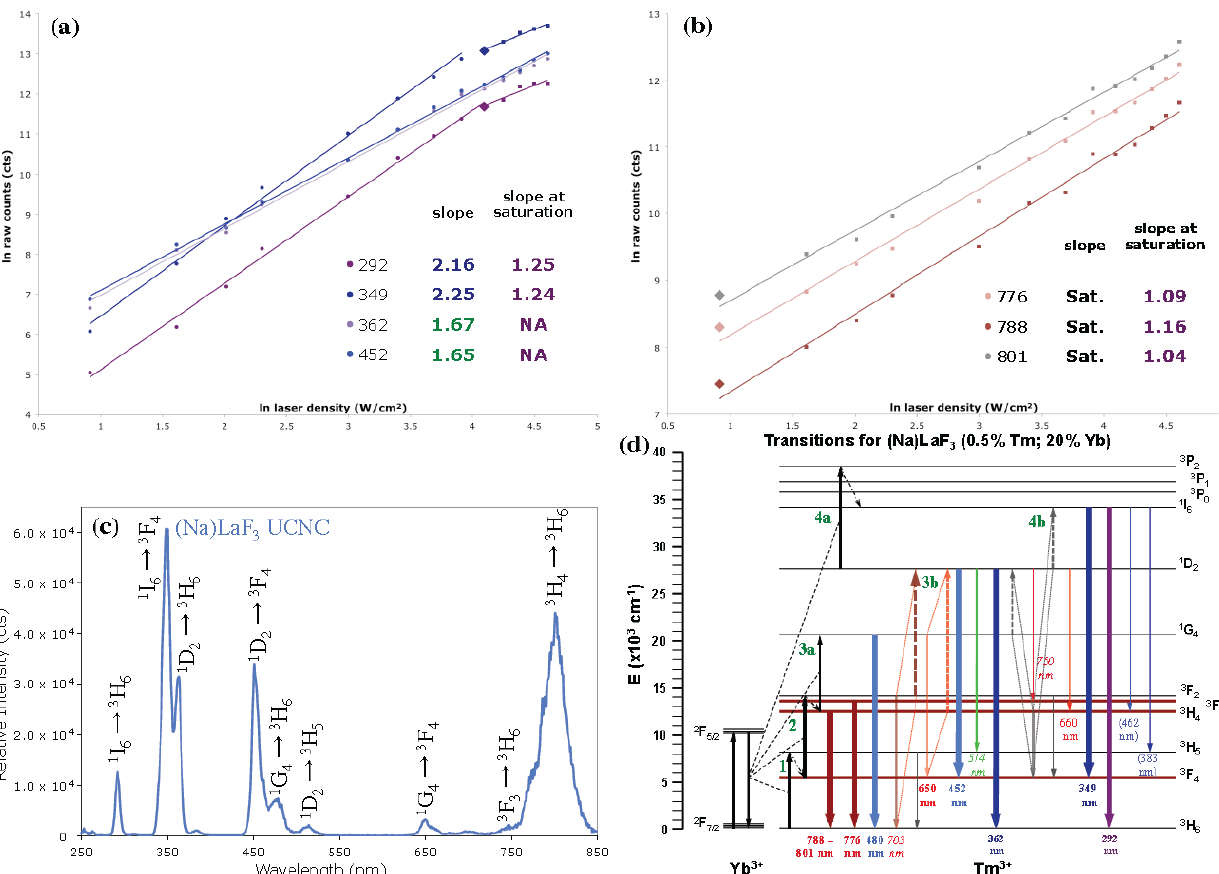
Figure 5. Emission intensity vs . 980 nm laser power density (W/cm 2 ), ln-ln IvP plot of UCNC in ( a ) UV/blue and ( b ) NIR regime, noting 0.5%Tm, 20%Yb codoped (Na)LaF 3 low power saturation of Tm 3+ 3 F and 3 H states; ( c ) Emission spectrum at 20 W/cm 2 and 3 4 ( d ) ETU transition diagram for Yb 3+ -Tm 3+ . Experimental conditions: 1 mg/mL solutions in toluene at 23 °C; 980 nm CW laser excitation varying from 2.5 to 100 W/cm 2